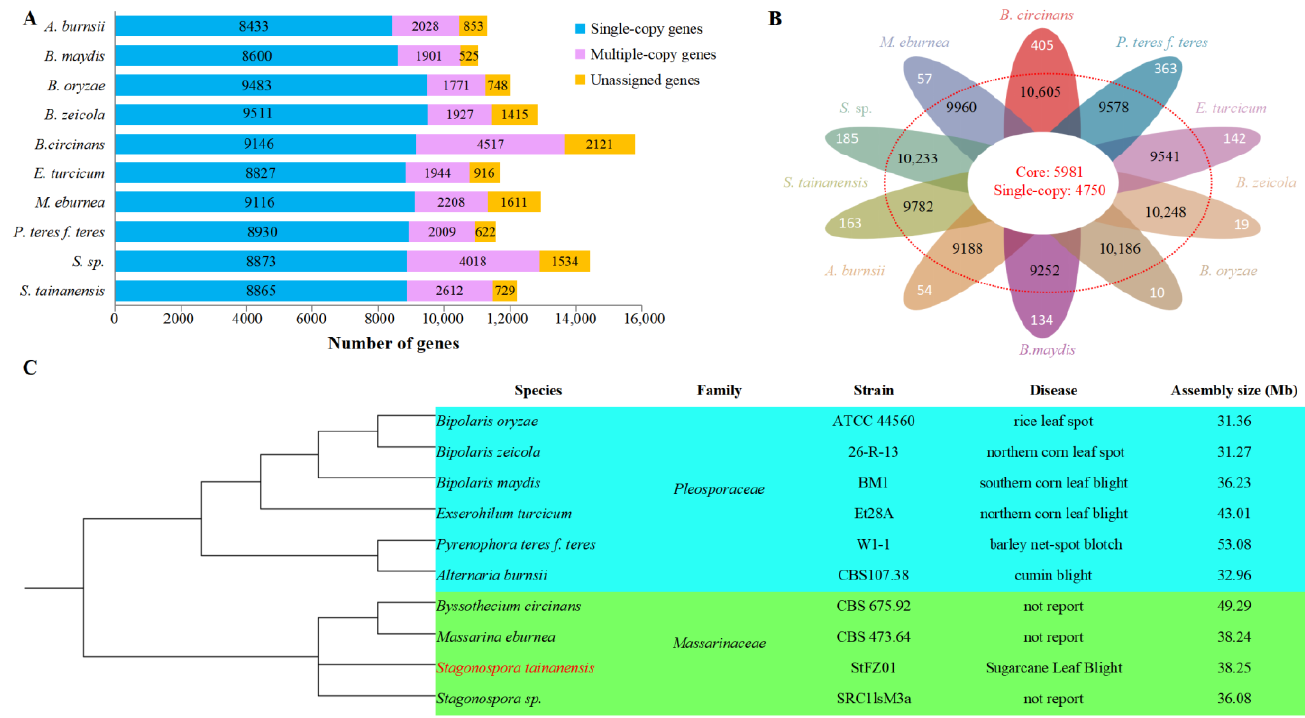
Table S17: Summary of secreted proteins and effectors; Table S18: Annotation of secondary metabolite biosynthetic gene clusters by AntiSMASH; Table S19: Summary of orthogroups analysis overall species; Table S20: Summary of orthogroups analysis per